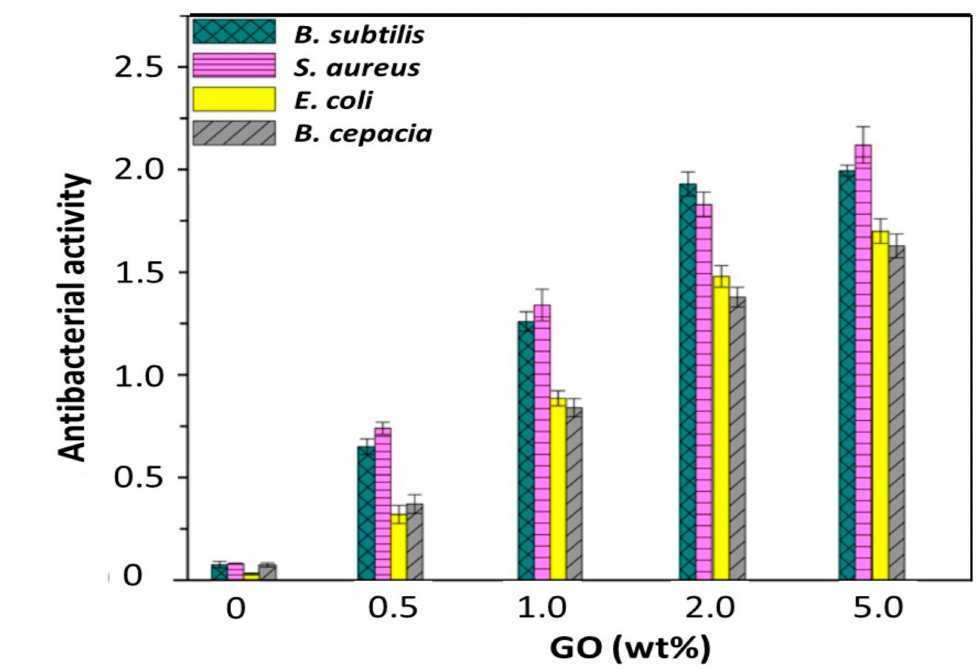
Figure 7. Antibacterial activity of PHBHHx and PHBHHx/GO nanocomposites against B. subtilis , S. aureus , E. coli and B. cepacia